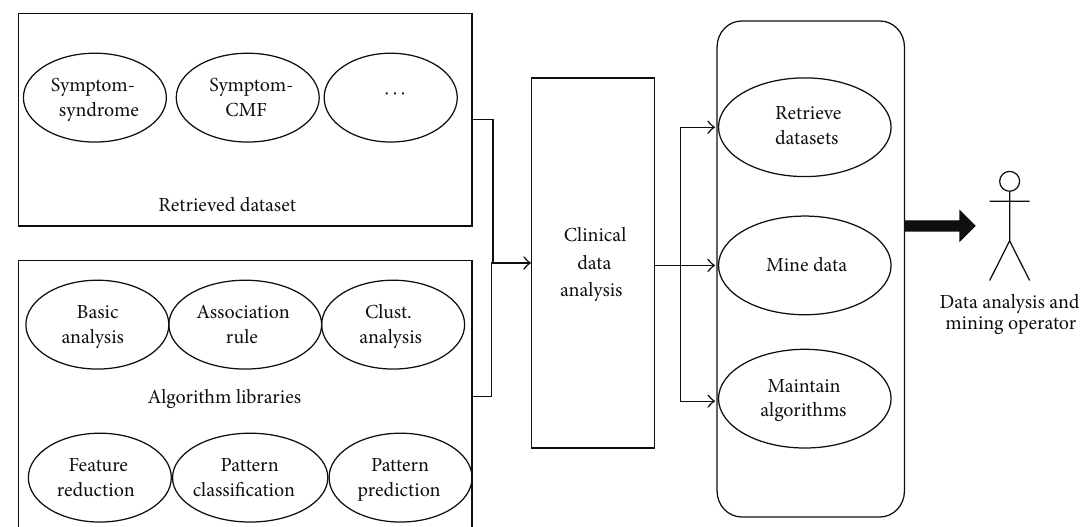
Figure 4: Overview design of intelligent data analysis.